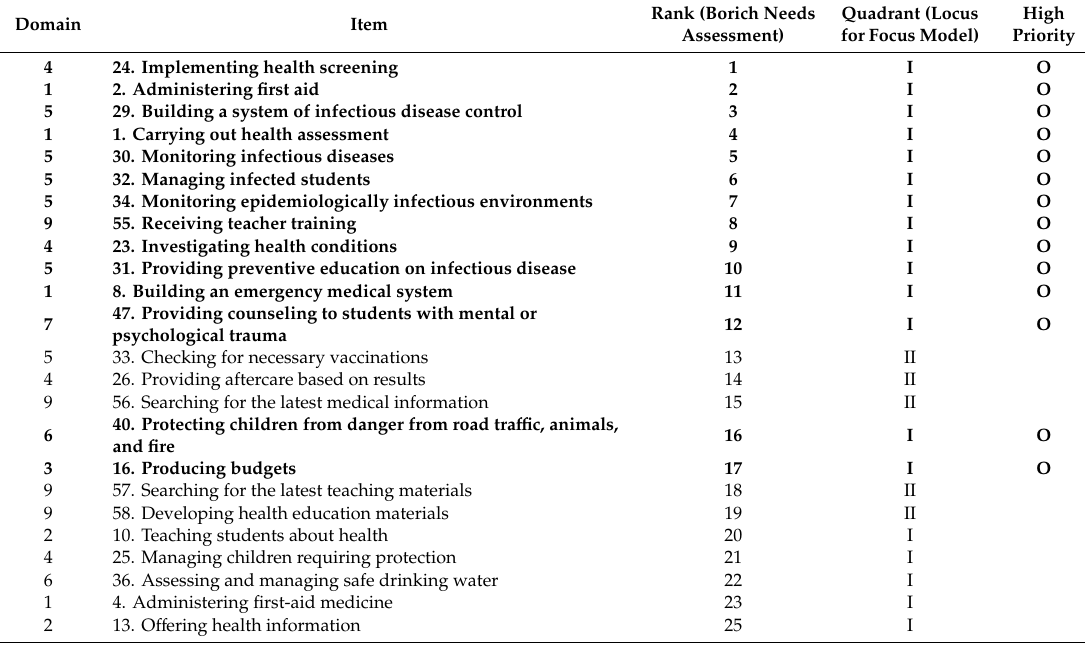
Figure 2. Priority of training needs in the locus for focus model. Table 3. High Priority Training Needs for School Health Staff Members According to Borich Needs Assessment and Locus for Focus Model.